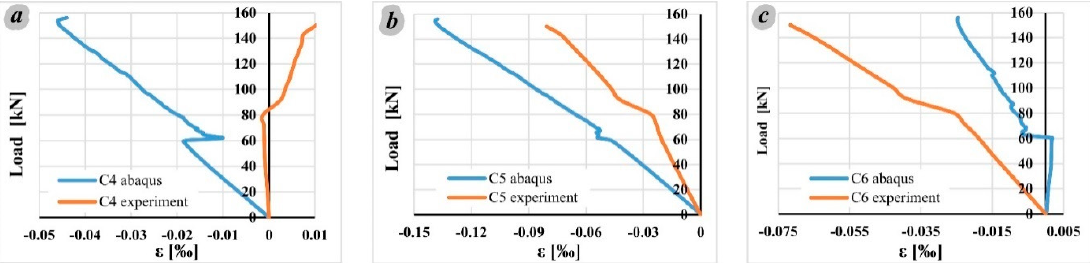
Figure 24. Experimental and numerical mid-span deflections of members: ( a ) W1, ( b ) W2, and ( c ) W3.